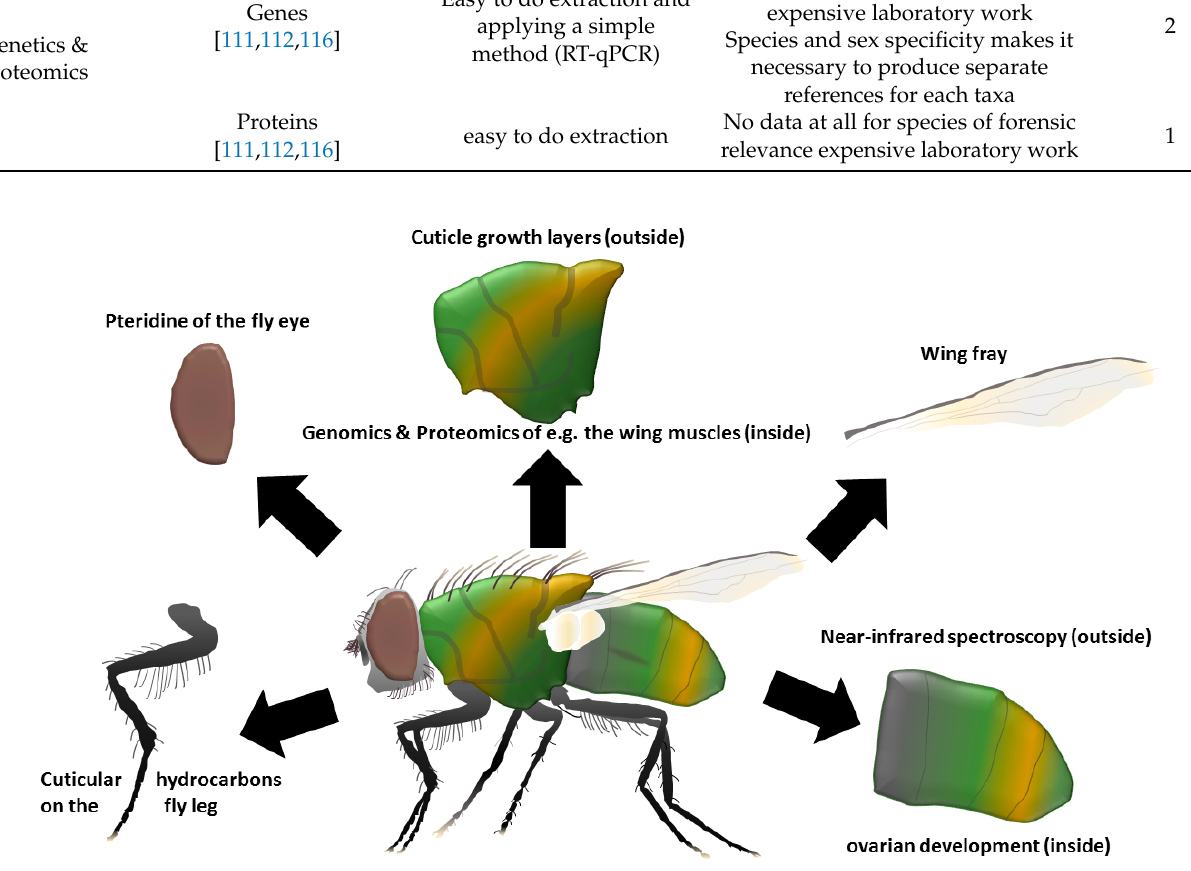
Figure 2. Different methods can use/analyse one and the same adult specimen by different techniques. The question that remains to be answered is whether the flies studied are actually the F1 generation of the population developing on the corpse. If the adults have little wing damage and a high proportion of males, this would indicate an F1 or later generation of adults, i.e., that they developed on the body [9]. If there are mostly female with a signifi- cant amount of wing damage, investigators could conclude that these flies came from the